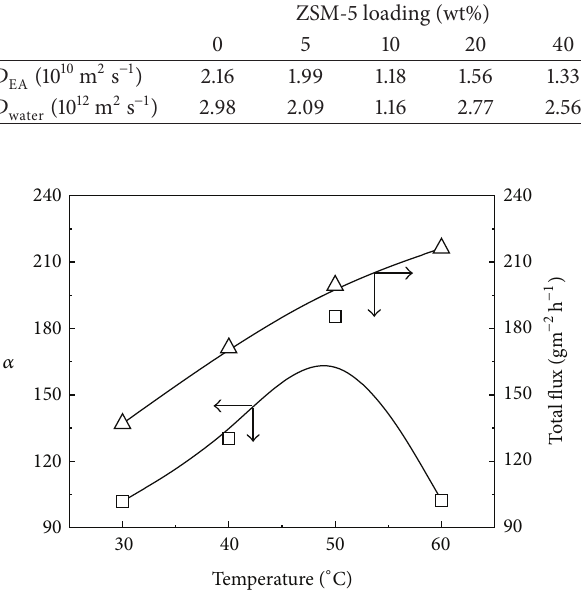
Figure 9: Effect of operating temperature on PV performance of PEBA-ZSM-5-10 membrane: separation factor and permeation flux (EA concentration in feed,